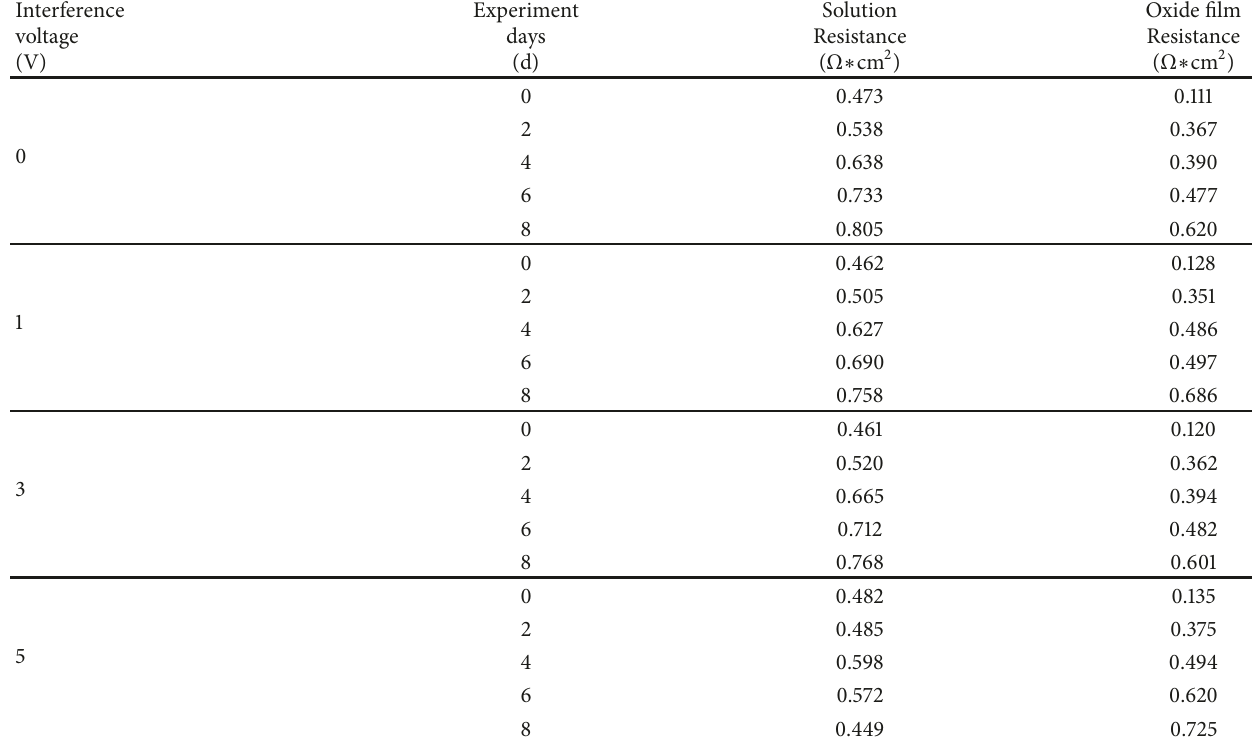
Table 6: The resistance parameters of the fitted equivalent